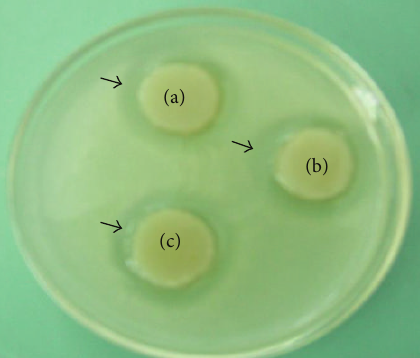
Figure 2: Chemical-in-plug method showing negative chemotaxis of (a) 4-chloro-2-nitrophenol, (b) 4-nitrophenol, and (c) 2,6- dichloro-4-nitrophenol by Bacillus sp. strain PA-2. minimal media, 2% bacto agar, and 4C2NP (100 mM) or 4NP